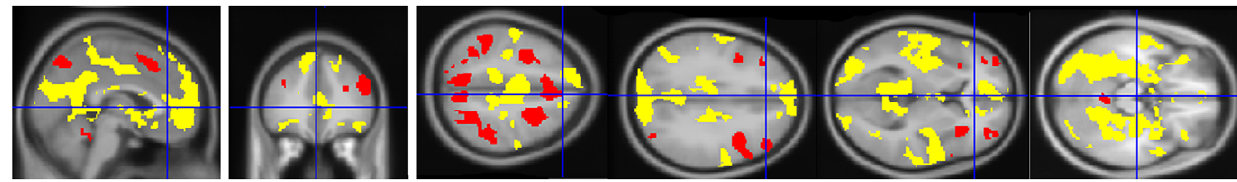
Figure 1. TPN (red) and DMN (yellow) masks derived from 3vs0 contrast task-related activation and deactivation respectively of HC (corrected for multiple comparisons, p=0.05, presented in neurological